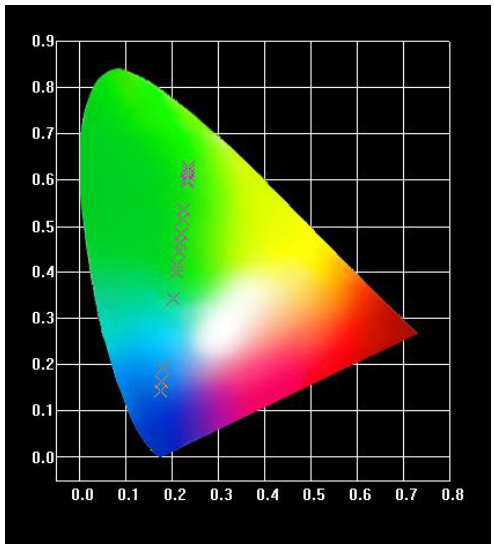
Figure 8. CIE chromaticity coordinates.